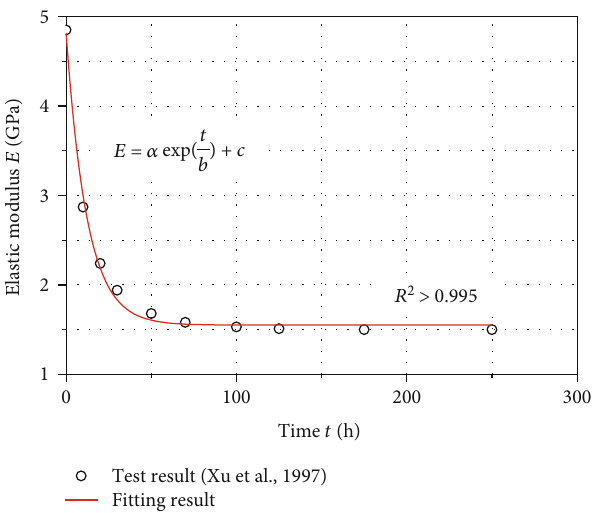
Figure 5: Relation between elastic modulus and time